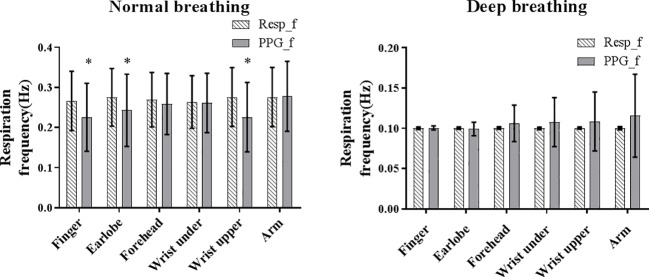
The mean (shaded bar) and standard deviation (segment) of reference (Resp_f) and PPG-derived (PPG_f) RFs under normal and deep breathing conditions. Asterisk marks the significant bias between Resf_f and PPG_f.